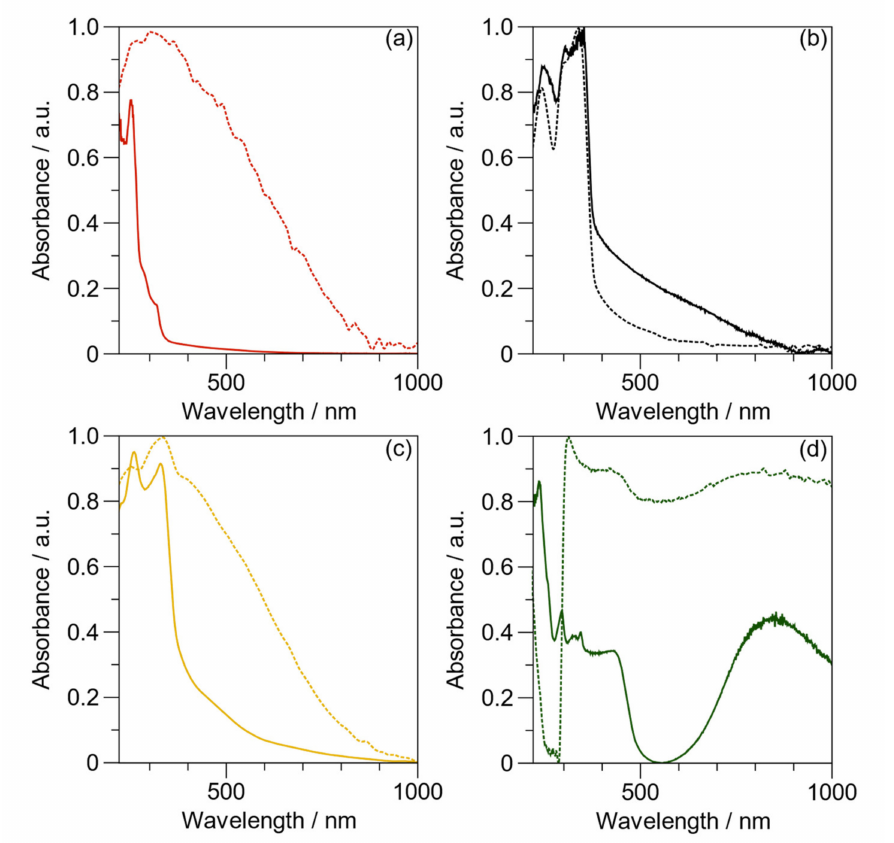
Figure 5. UV–Vis spectra of the samples in solution (solid line) and solid-state (dash line): ( a ) macro-RAFT; ( b ) poly( N -vinylcarbazole) (PVK); ( c ) PAAMP- b -PVK; ( d ) BL